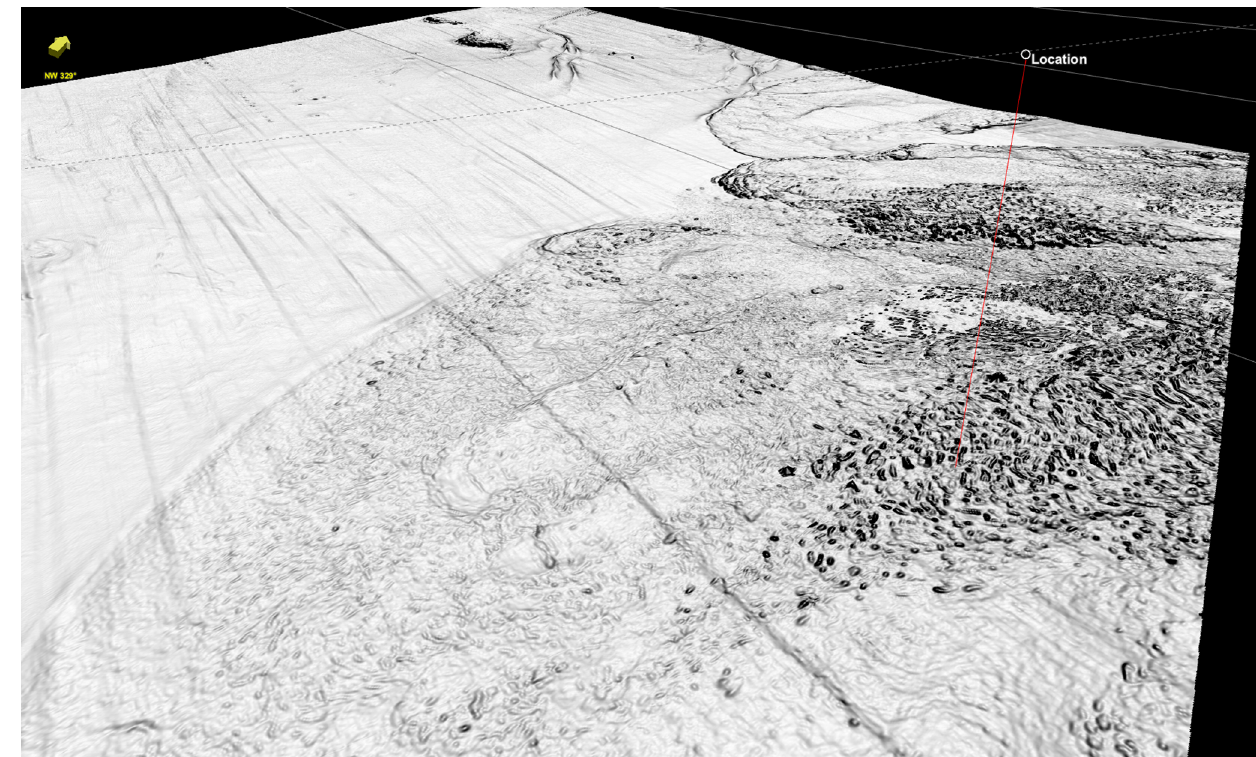
Figure 2. Three-dimensional view of topography around the drill site C9033. Rugged features indicate occurrences of mass transport. Seafloor topography detection from the seismic survey data (JOGMEC, 2013, 2014).